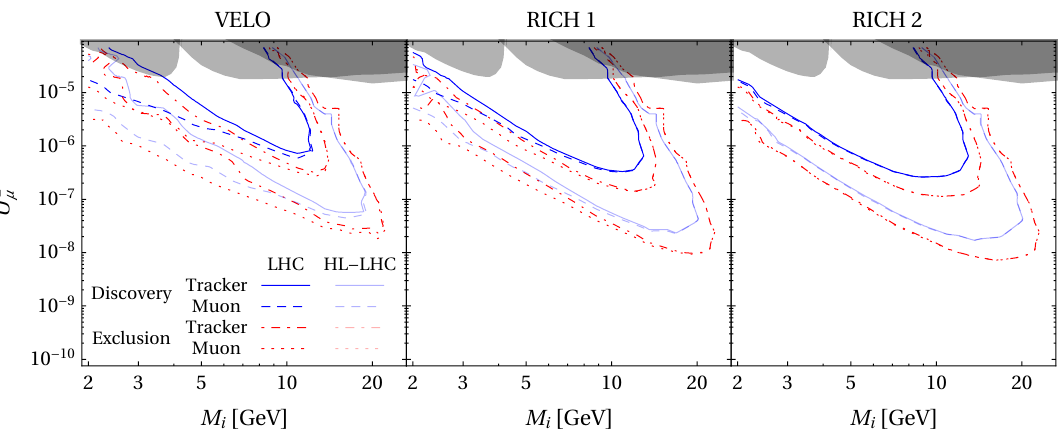
Figure 8. Comparison of the sensitivity reach of LHCb at 13 and 14 TeV with 30 and 380 fb (cid:0) 1 for pure muon mixing, under the assumptions that the neutrino has to decay within the VELO and before or within the (cid:12)rst or second RICH,